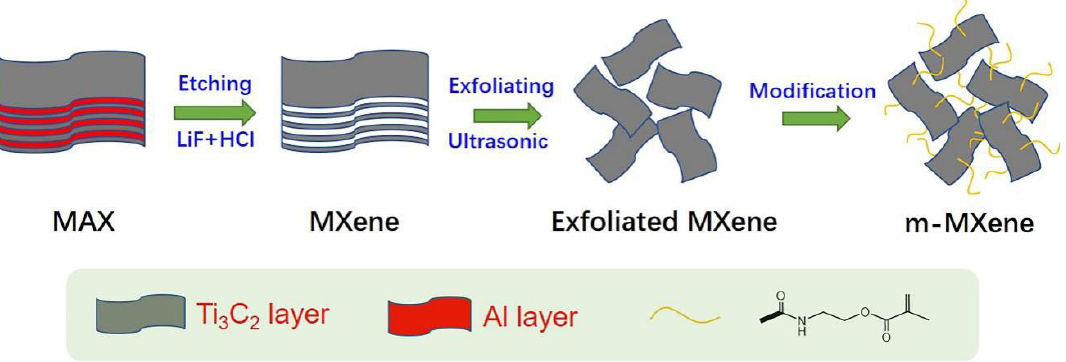
Figure 11. Schematic diagram of the fabrication process of functionalized MXene nanosheets.